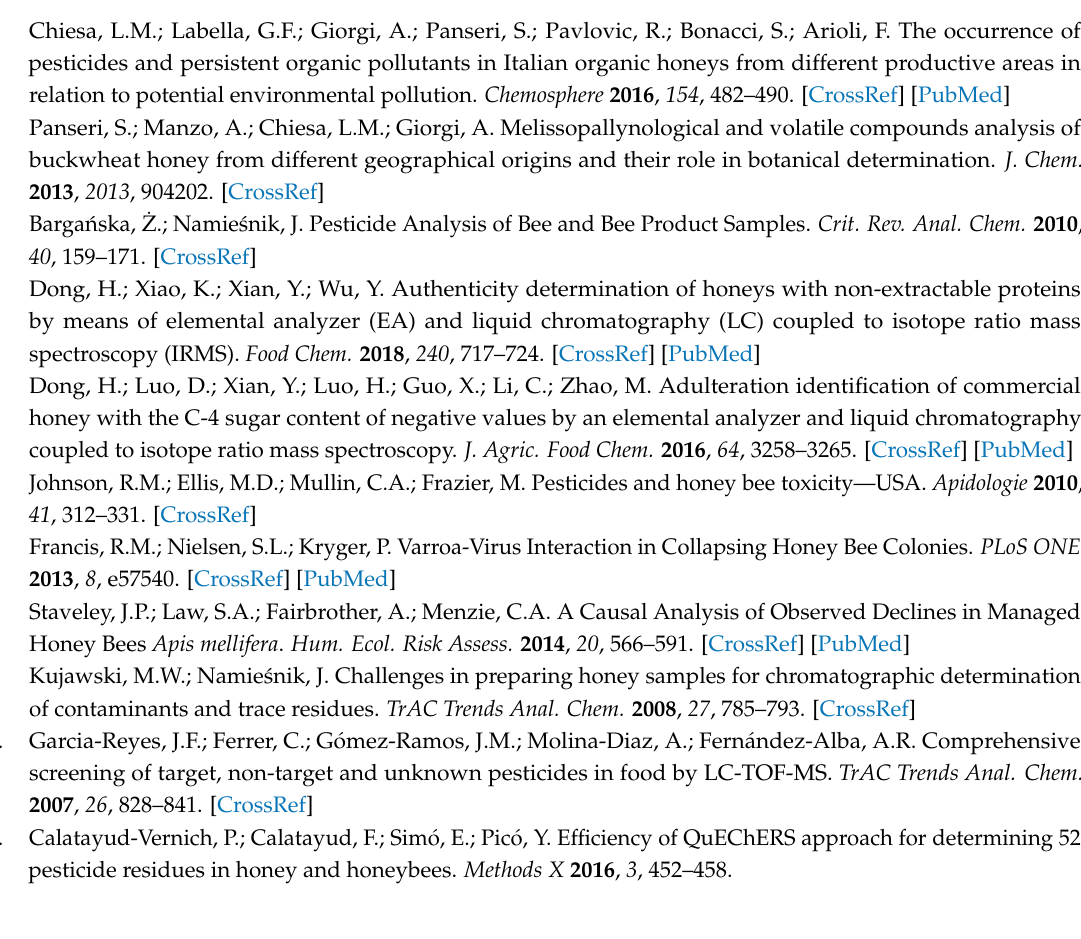
Supplementary Materials: The following are available online. Table S1: Chemicals and analytical procedures used for determination of pesticide residues, Table S2: Linearity and matrix effects, Table S3: The analytical parameters of the QuEChERS methods in spiked honey and honeybee samples using LC-MS/MS and GC-MS/MS analysis, Table S4: Pesticide residues determined in honey and honeybee samples collected from three counties of Pomerania (concentration with expanded uncertainty). Sample numbers: 1–5 from Gda´nsk County, 6–10 from Kartuzy County and 11–15 from Tczew County, Table S5: Comparison of analytical performance of different procedures based on the application of QuEChERS approach with clean-up dSPE step for determination of pesticide residues in honey (A) and honeybee (B)